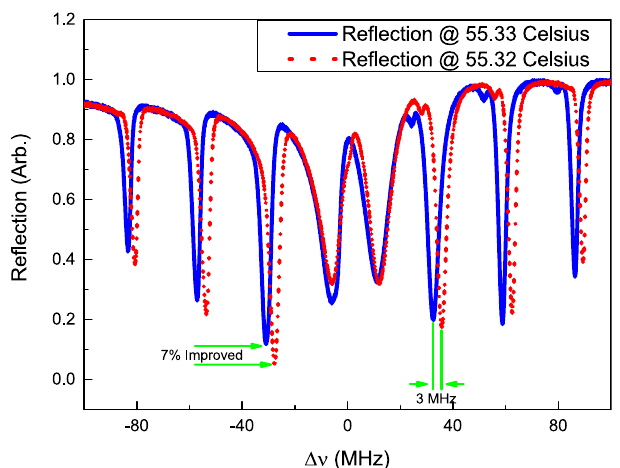
Figure 8. Experimental example of using a tunable PSFBG to improve the impedance matching of resonant peak. Here the Bragg wavelength of PSFBG is tuned by changing its temperature. The blue curve is the reflection spectrum of 3.4 m long PSFBG-F-FBG resonator when temperature of PSFBG is 55.33 °C, and the red dot curve is the reflection spectrum of the same PSFBG-F-FBG resonator when temperature of PSFBG is 55.32